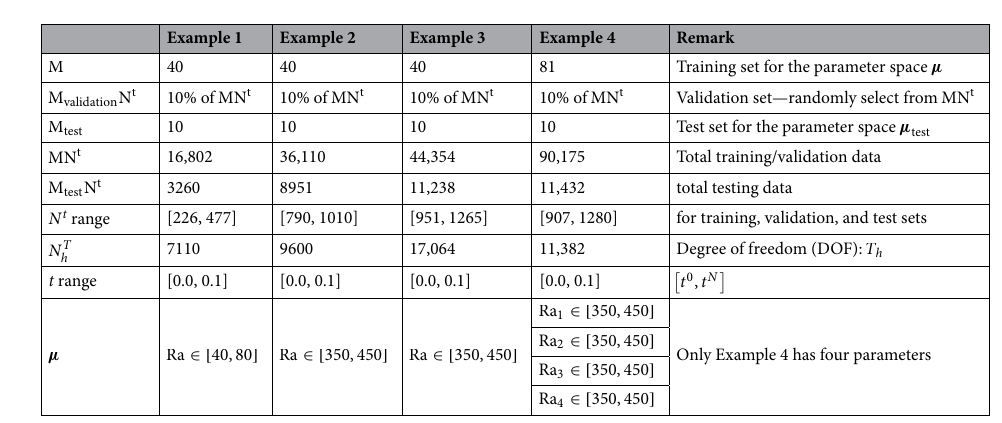
Table 1. Summary of main information for each